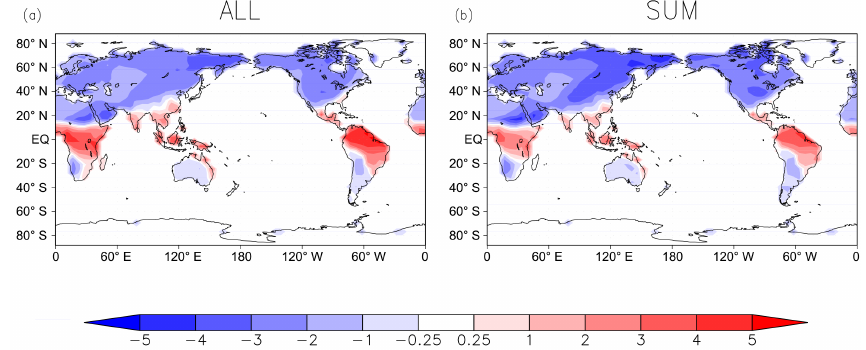
Figure 11. Spatial patterns of (a) actual temperature change and (b) reconstructed temperature change (SUM = ALL − noALB + ALL − noRGH + EVA − CTL). Unit is Kelvin for